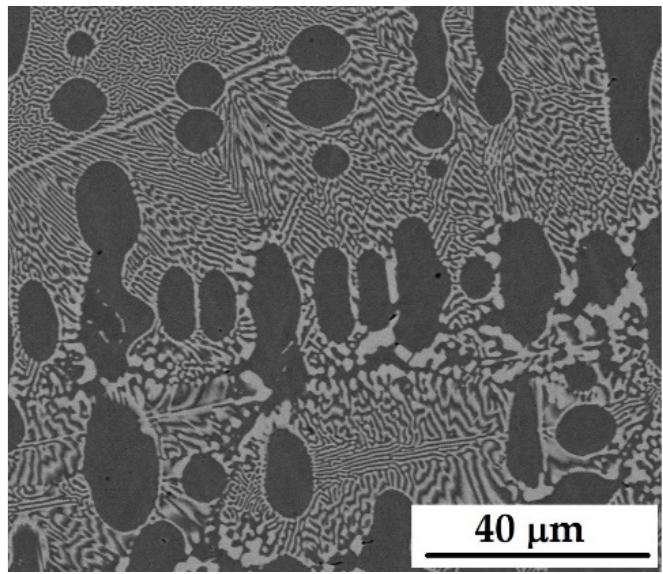
Figure 1. Structure of master alloy Ni-Mo.